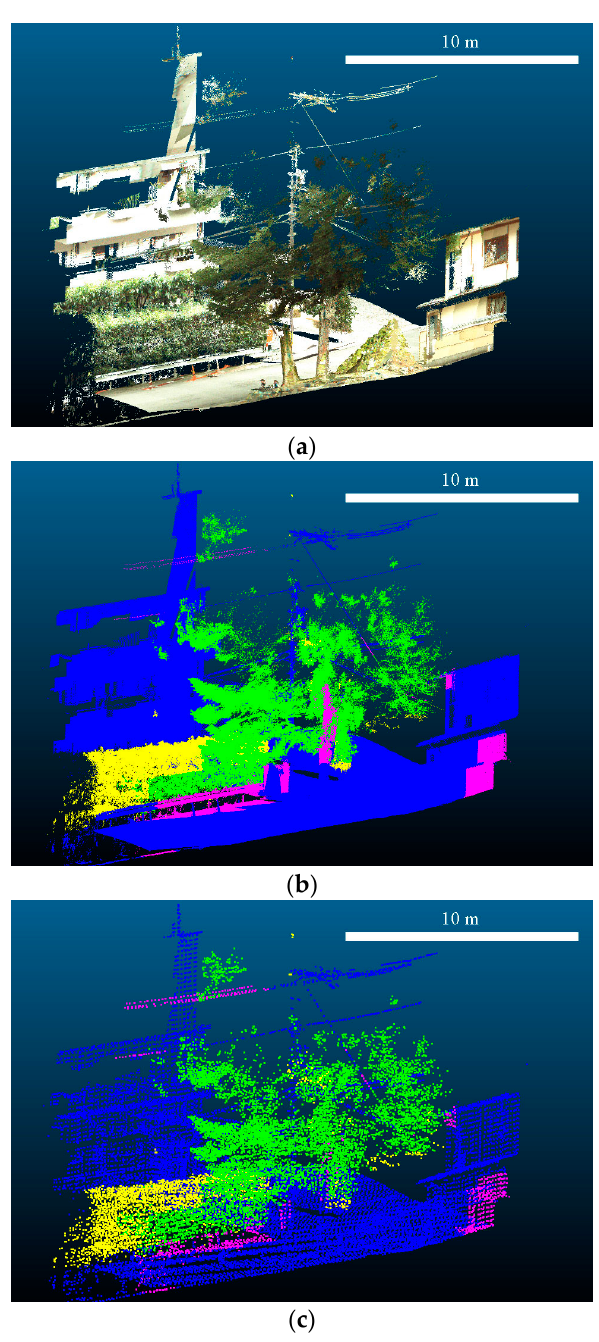
Figure 10. Accuracy assessment of vegetation extraction: ( a ) colored point cloud; ( b ) verified result for original point cloud; and ( c ) verified result for 0.2 m voxel. ( b , c ) Green, blue, pink and yellow denote true positive (TP), true negative (TN), false positive (FP) and false negative (FN), respectively.